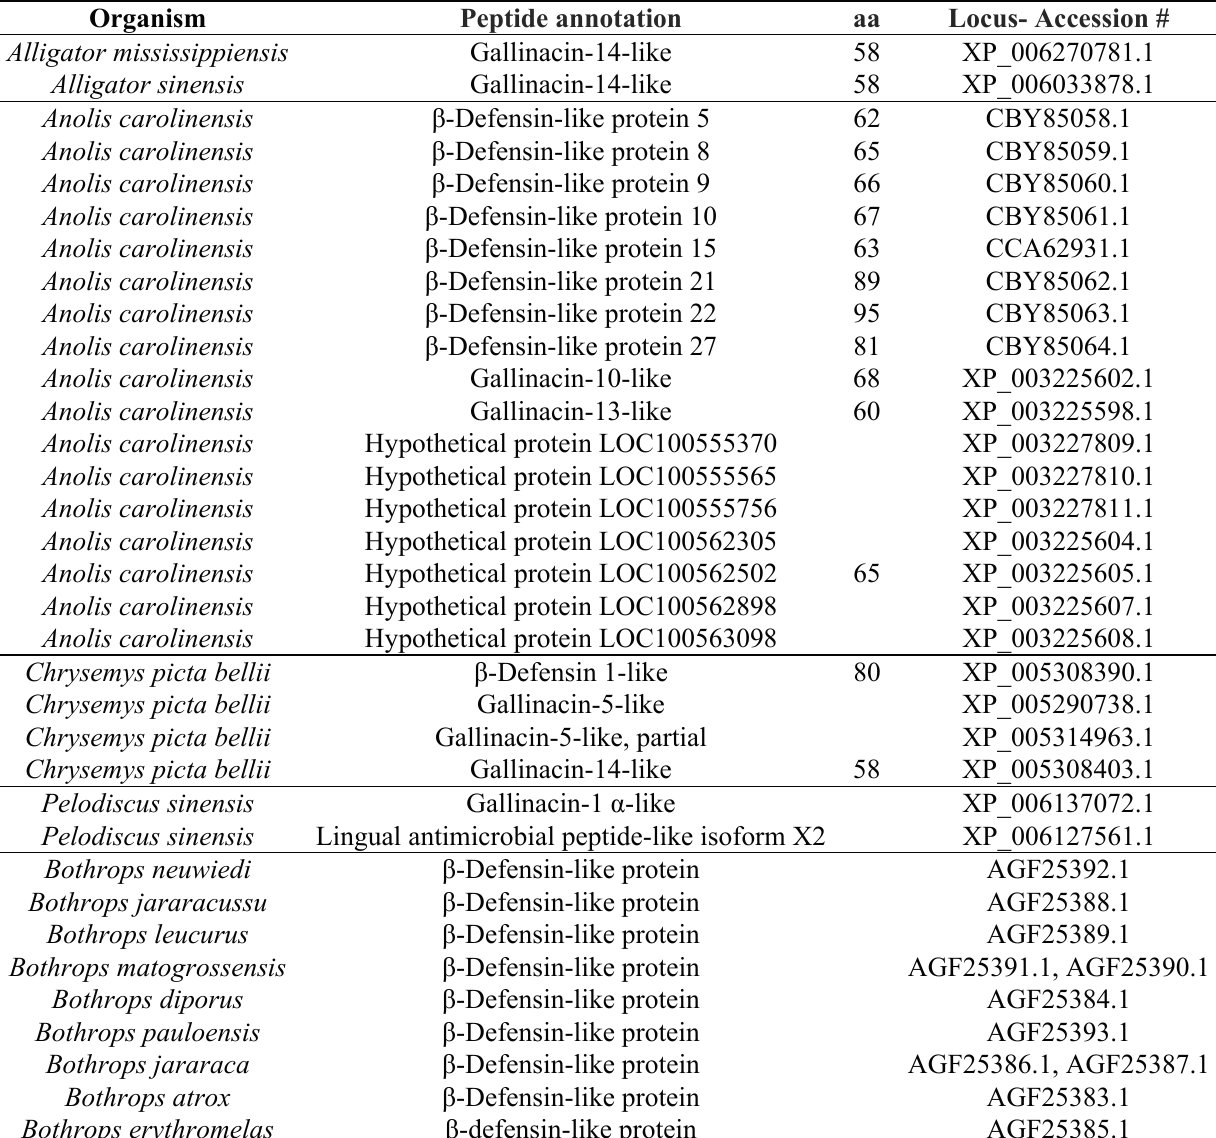
Table 2. Predicted defensin-like protein genes in multiple reptilian